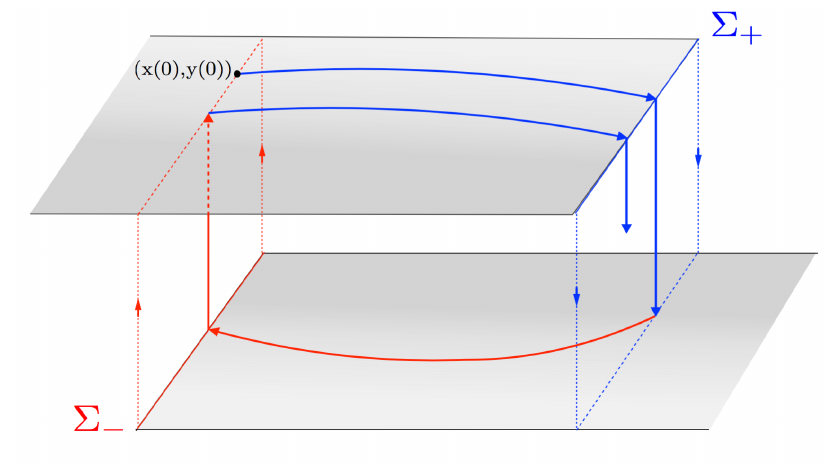
Fig. 1 The transition mechanism between systems ( S U ) and ( S L ). We use blue colour for solutions of the upper system and red colour for solutions of the lower one. We can see also the falls at the line Σ + and the rises at the line Σ − . Note that our formulation is equivalent to write the system